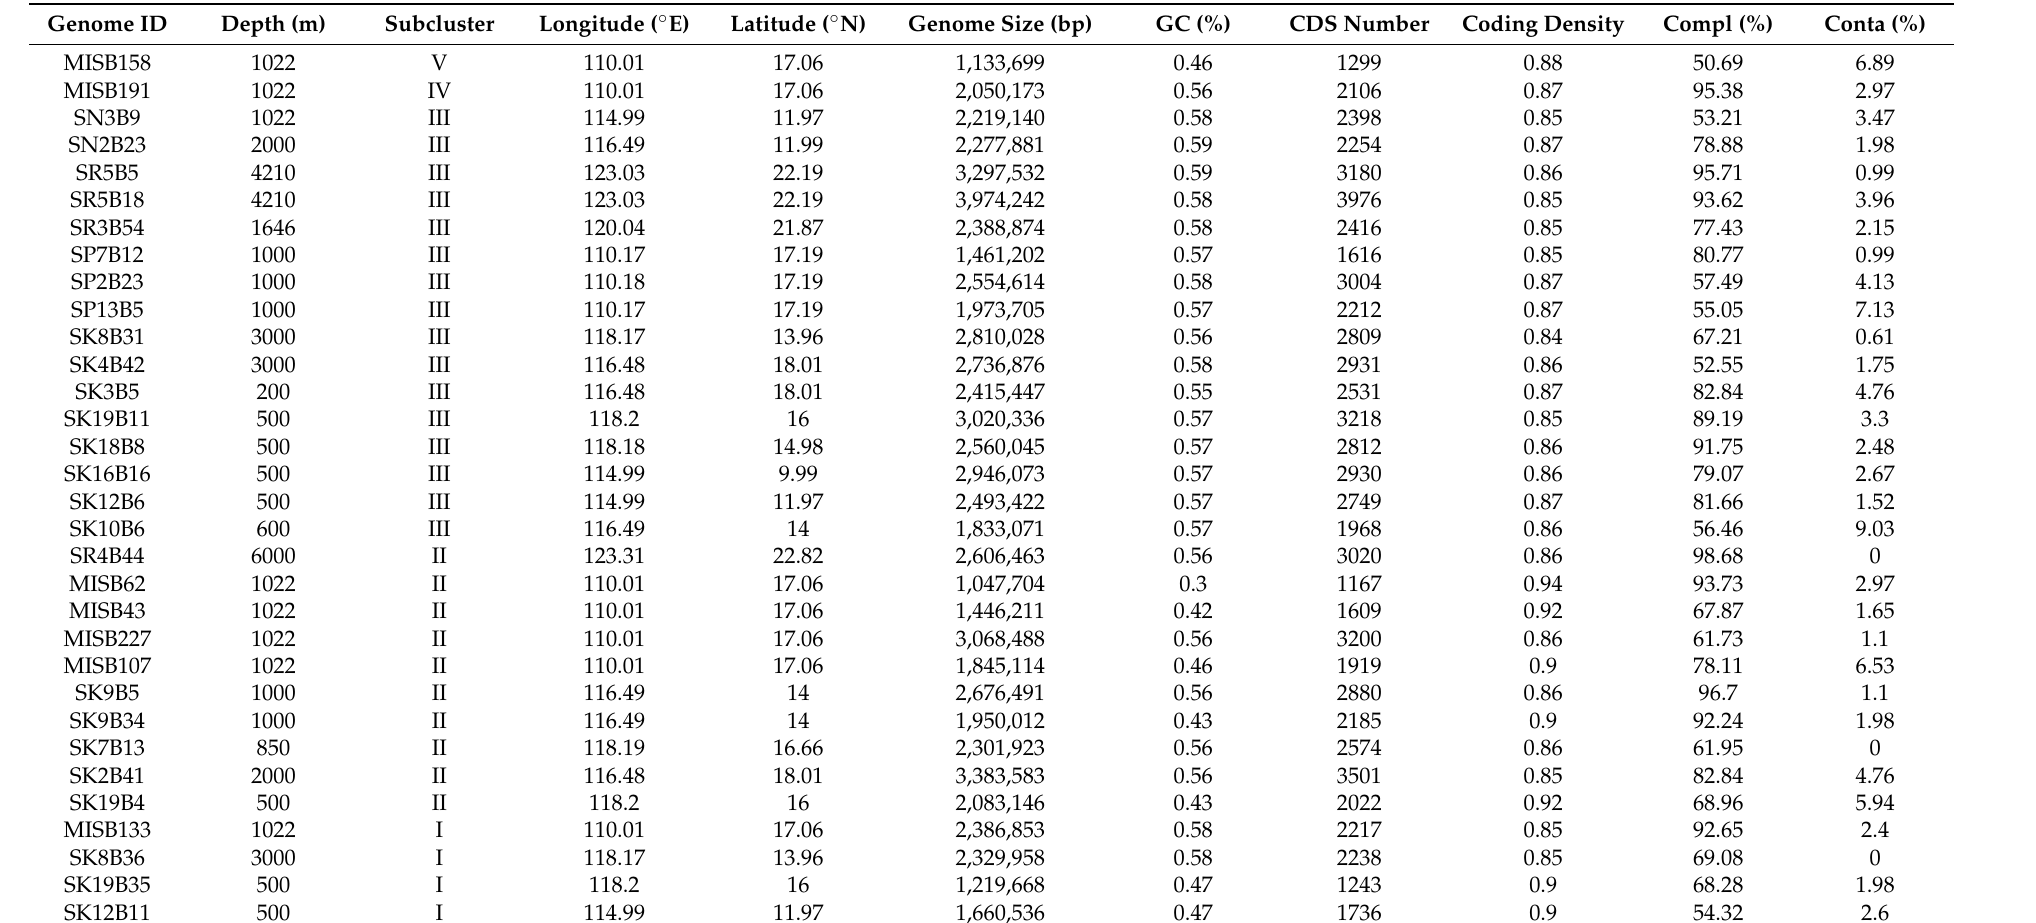
Table 1. Genomic information of SAR202 MAGs in this